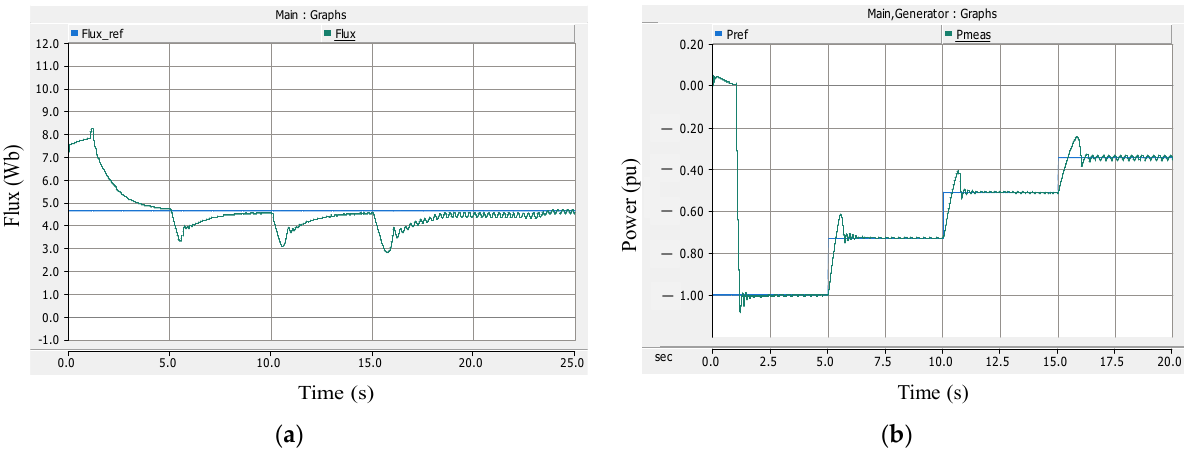
Figure 21. ( a ) Flux control; ( b ) power control during rotor speed variation.